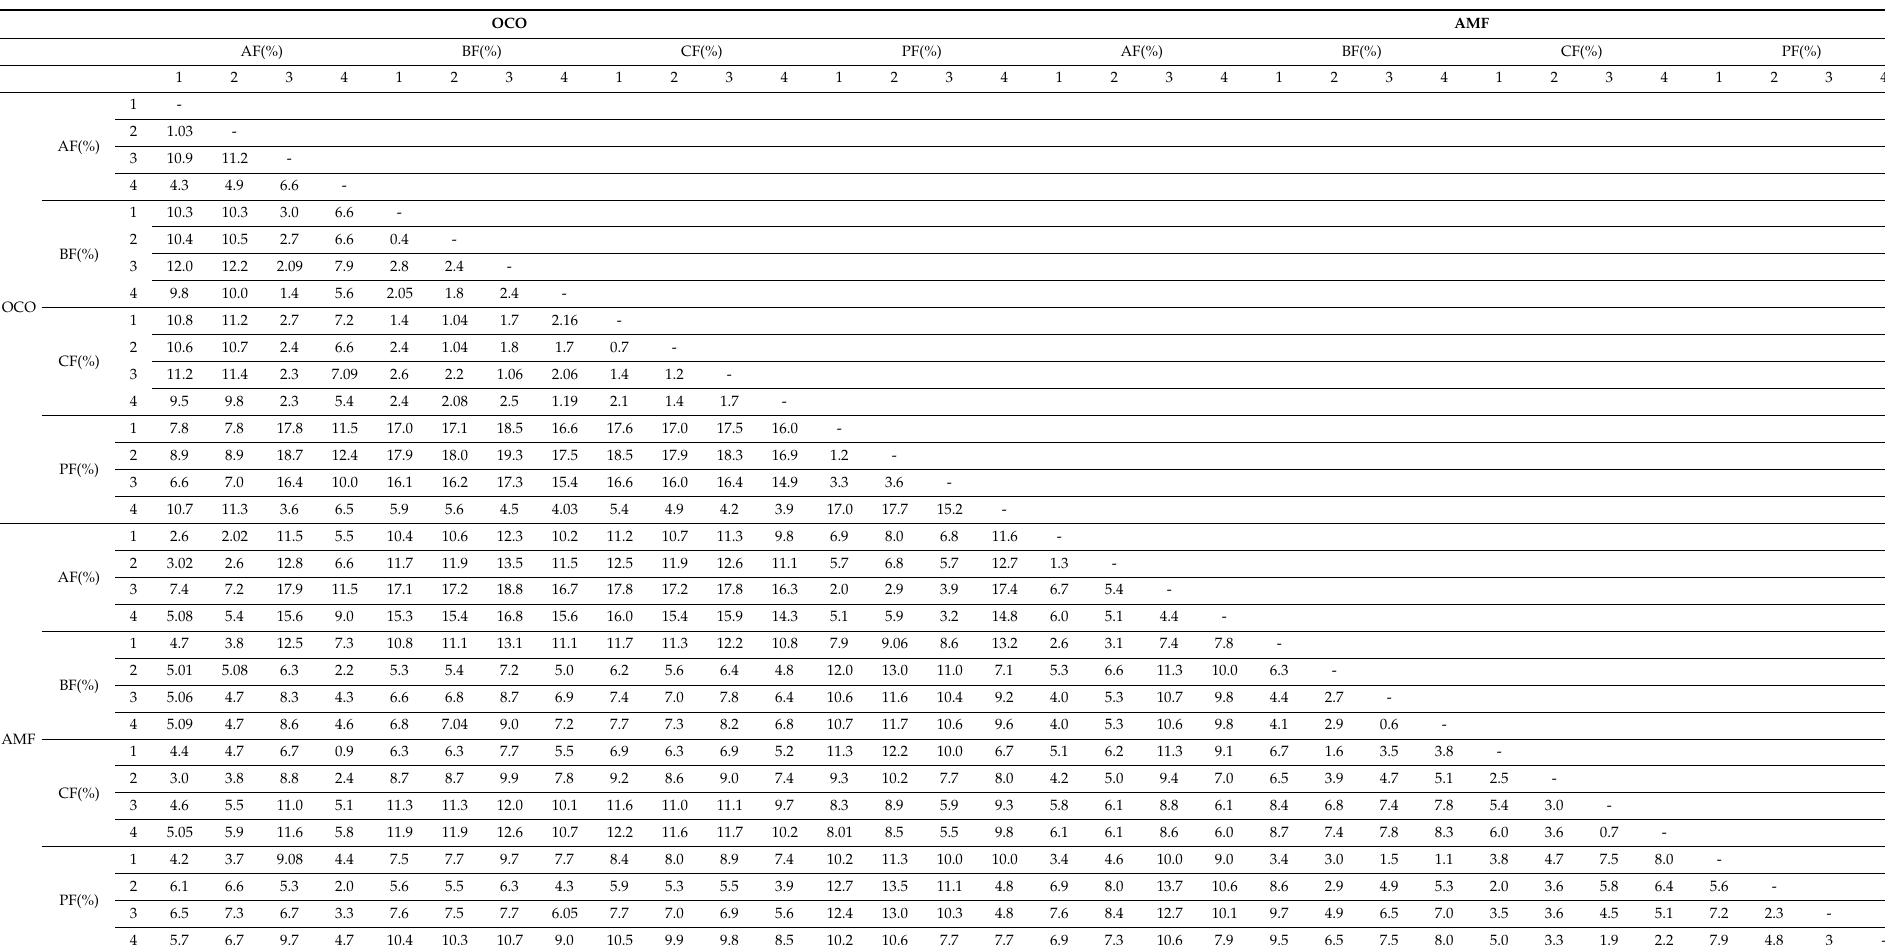
Table 4. Effect of different fibers, AC (acid casein), WPC80 (whey protein concentrate) and OCO (organic coconut oil) or AMF (anhydrous milk fat) on color differences of PCS (processed cheese sauces) expressed by NBS units ( ∆ E × 0.92) measured with CVS (computer vision